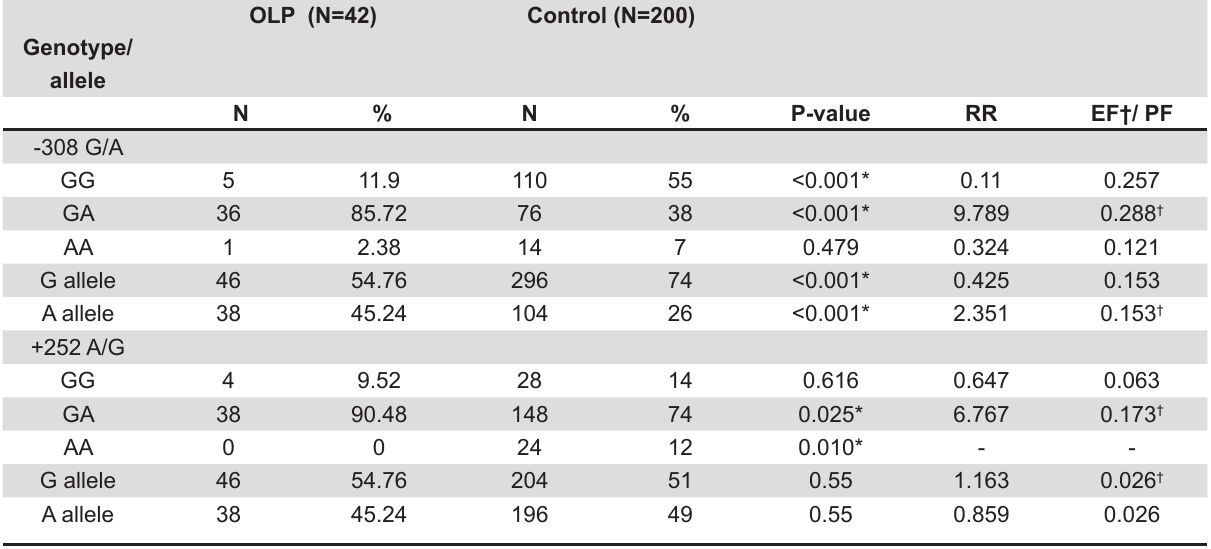
Table 1- Genotype and allele frequencies of TNF- α and TNF-β variants in oral lichen planus patients and matched controls